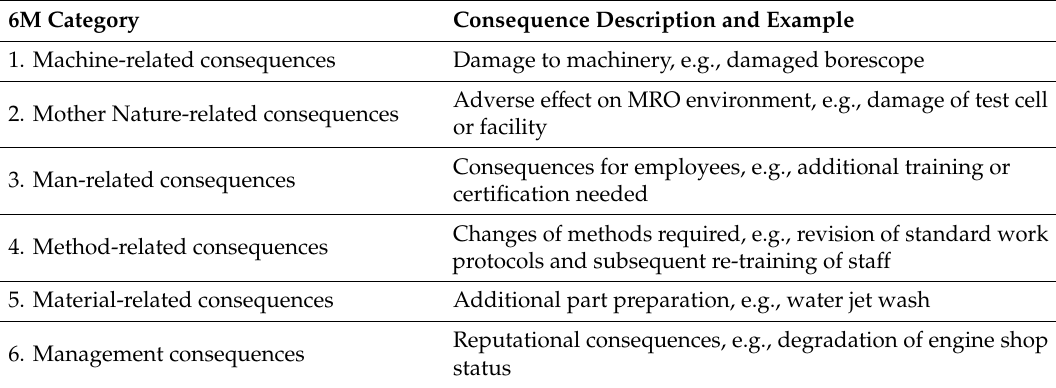
Table 3. The 6M categories for immediate consequence for the MRO service provider with description and